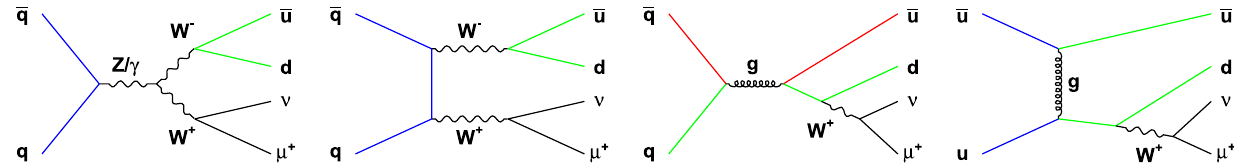
Fig. 11 The leading order qq → W + ud diagrams. The first two diagrams show electroweak processes giving rise to on-shell WW pair production, and the second two are the basic diagrams involving a gluon, referred to here as QCD